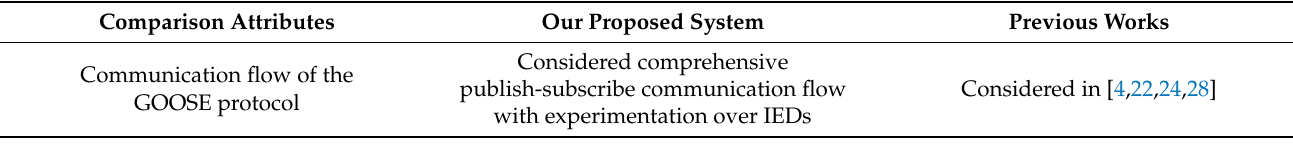
Table 2. Comparison of our proposed system with previous